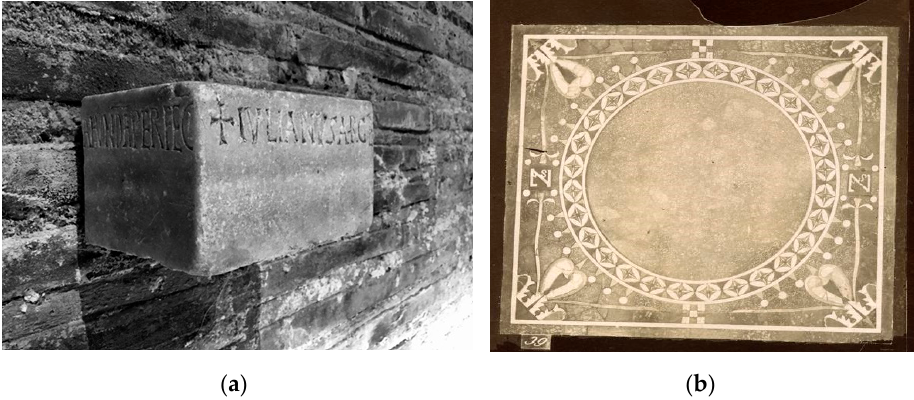
Figure 12. Inscriptions and monograms of Julian Argentarius: ( a ) reliquary (photo: G. Gardini); ( b ) original marble inlaid panel (photo: under concession of Fondazione Federico Zeri, Bologna, inv. 3431, copyrights cleared).